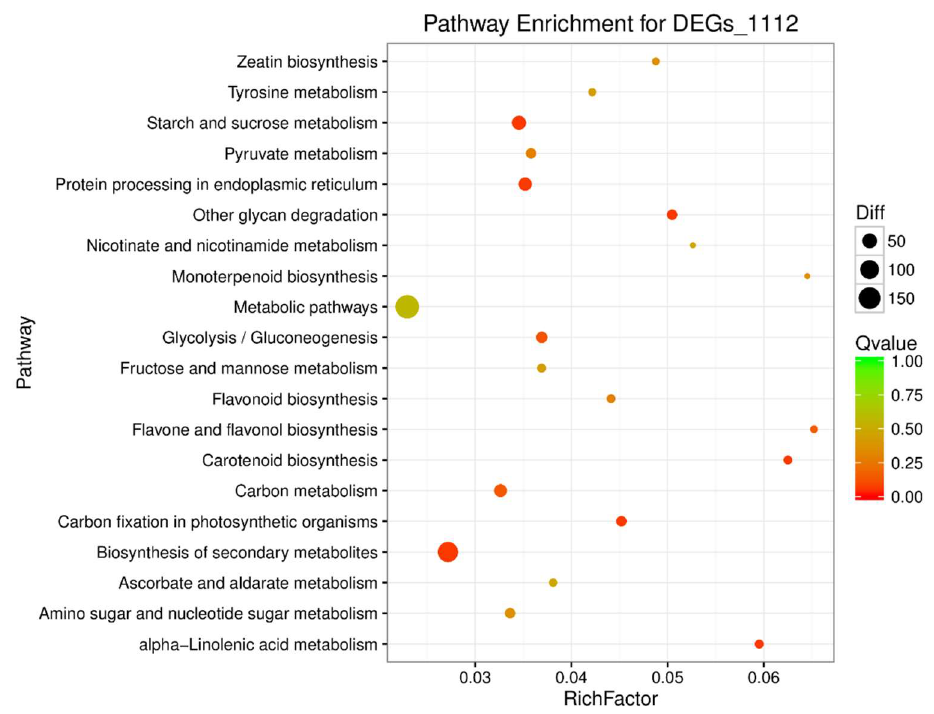
Figure 3 . The thirty top GO assignments of 1112 DEGs. Blue: molecular function, green: cellular component, and red: biological process. The Y-axis represents the GO Term; the X-axis represents the number of DEGs for each GO Term. “*” indicates significant enrichment of the GO Term.